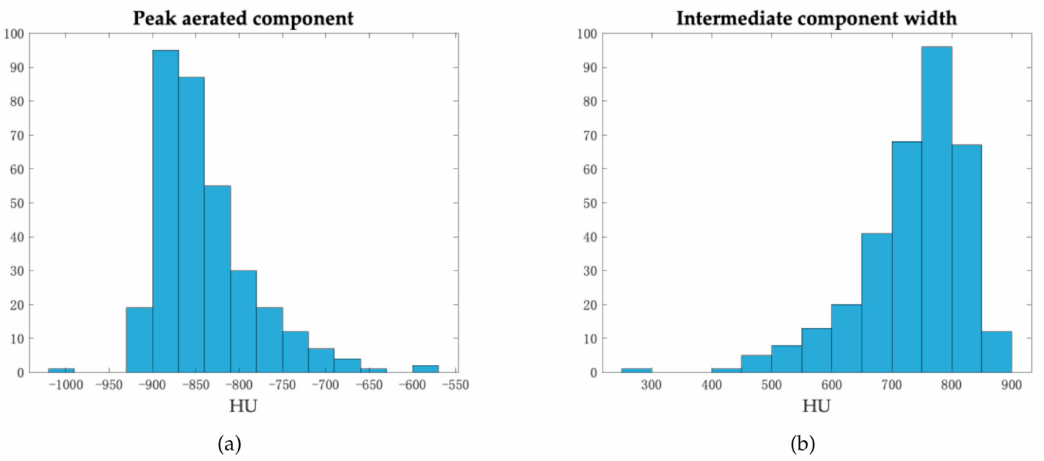
Figure 9. Histograms of the distributions of ( a ) position of the peak of the aerated component and ( b ) width of the intermediate